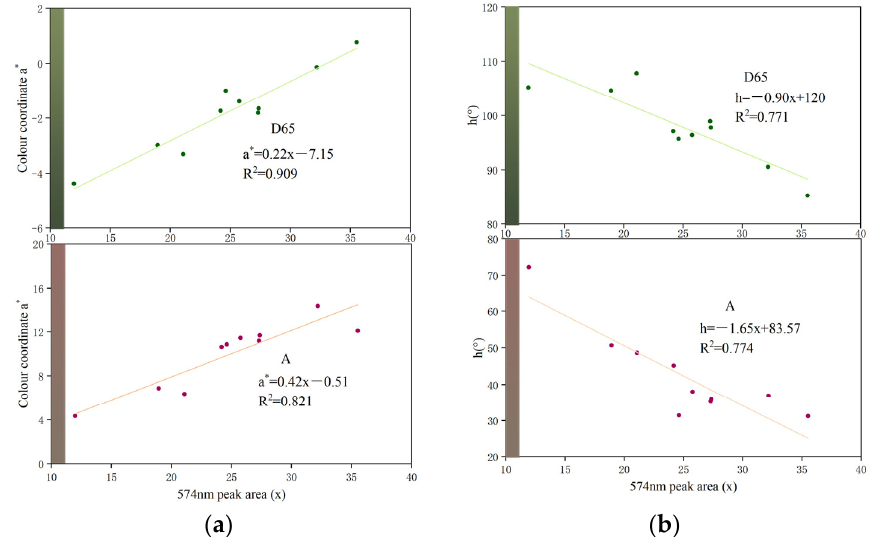
Figure 10. The colorimetric coordinate a* and the hue angle h(°) are related to the peak area of absorption at 574 nm. Under the D65 and A light sources, a* is positively correlated with the area of the absorption peak ( a ) whereas h is negatively correlated with it at 574 nm ( b ).